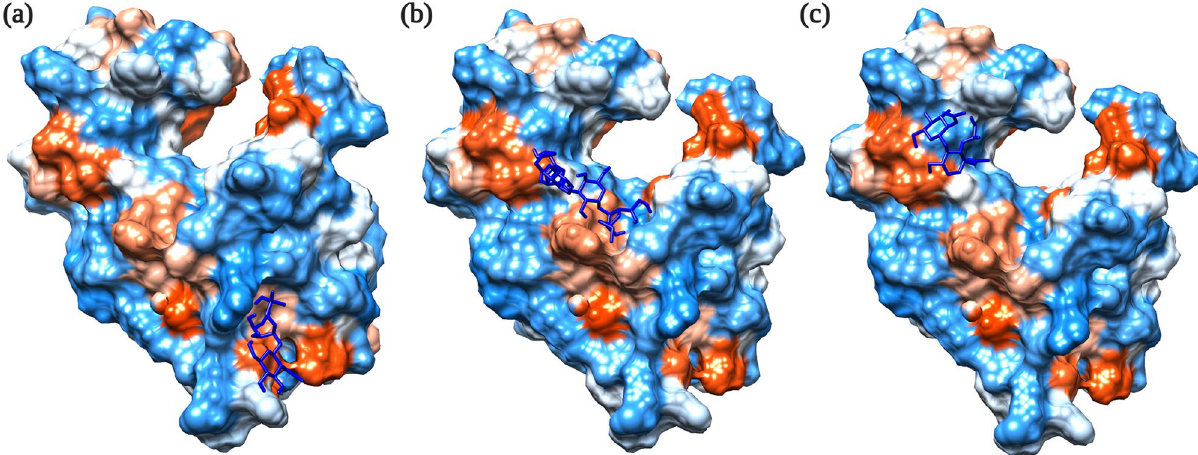
Figure 7. Hydrophobicity of protein–ligand complexes. The 3-dimensional structure of CL1-C600M2-lysin is represented using the hydrophobicity attribute in Chimera, complexed with ligands ( a ) WTA; ( b ) TS and ( c ) PG. The protein surface is colored based on hydrophobiciy of the underlying residues ranging from blue, being highly hydrophilic to red, being highly hydrophobic. All ligands are represented in dark blue irrespective of their